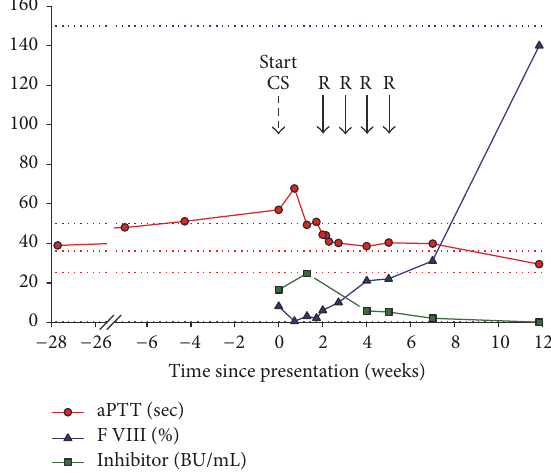
Figure 1: Development of aPTT, factor VIII, and inhibitor titer. Biological development before and after initial presentation in the emergency room. Dotted lines represent the limit of reference values. Corticosteroids (CS) were administered daily after presentation; ritux- imab (R) was administered once a week for 4 consecutive weeks (from Day 14)